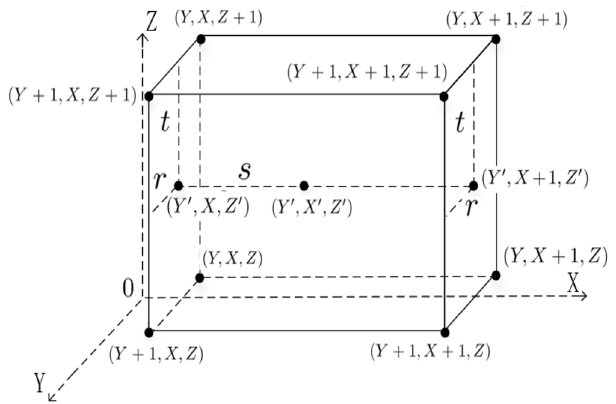
Figure 15. Coordinate map relationship for